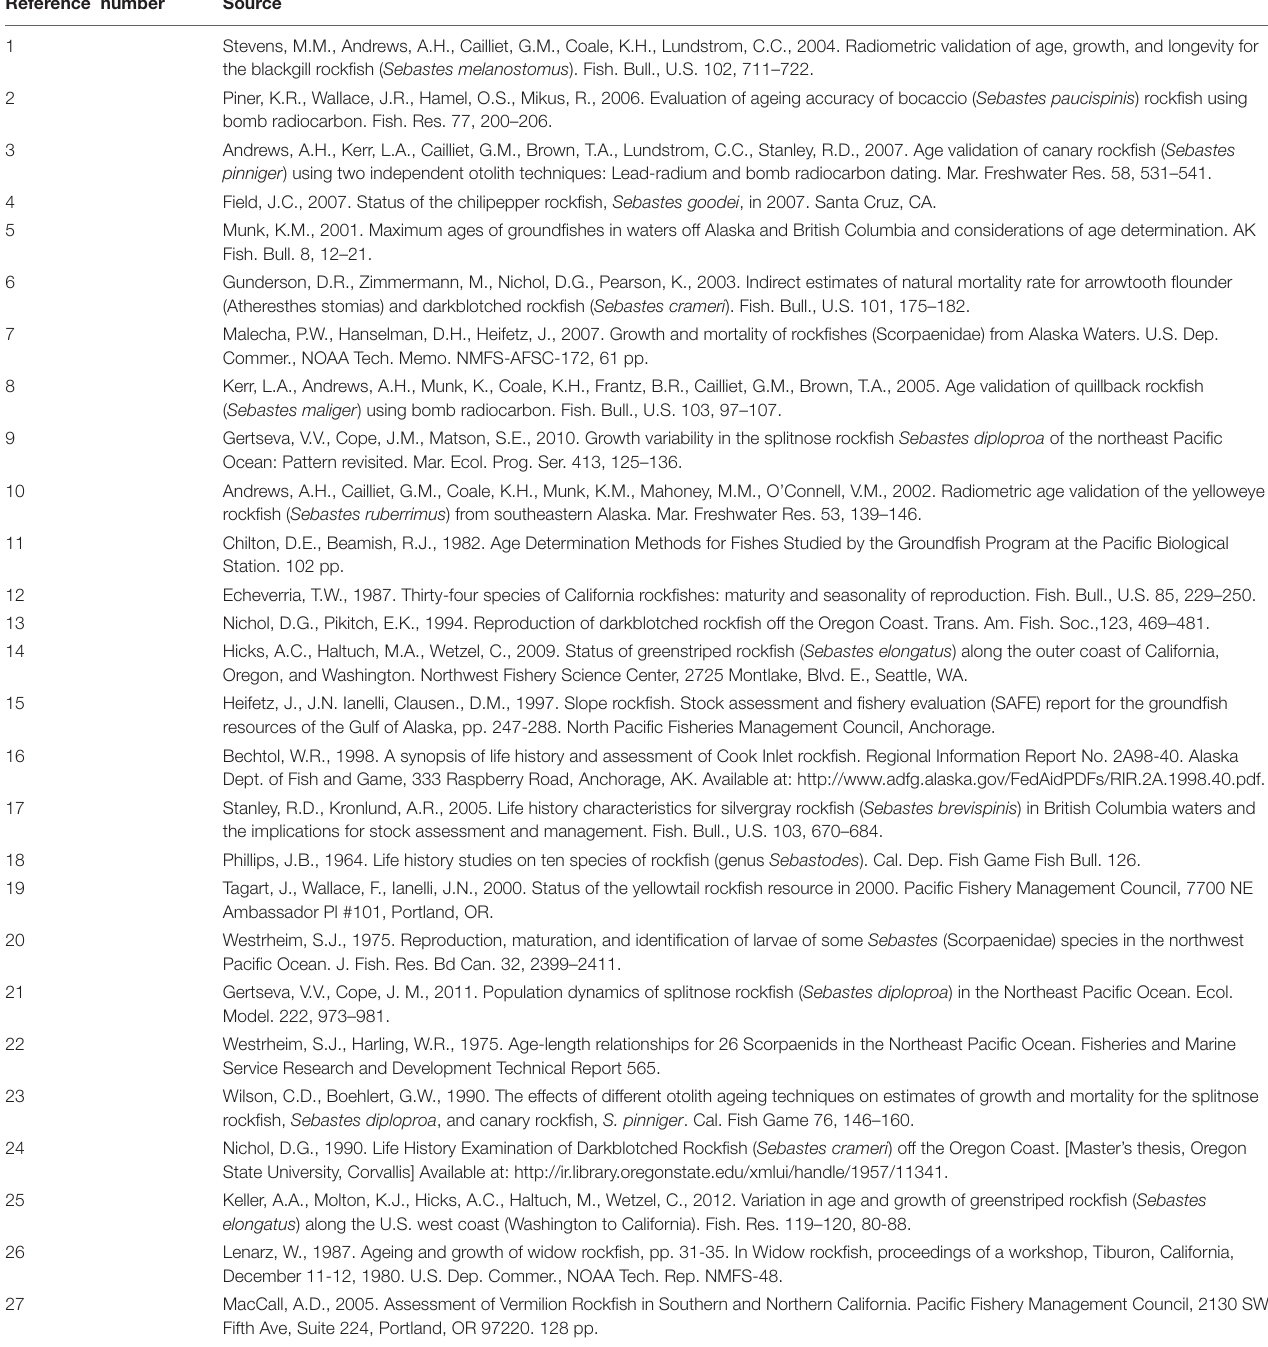
TABLE A1 | Reference number with associated source from the life history parameters of rockfish from Table 1